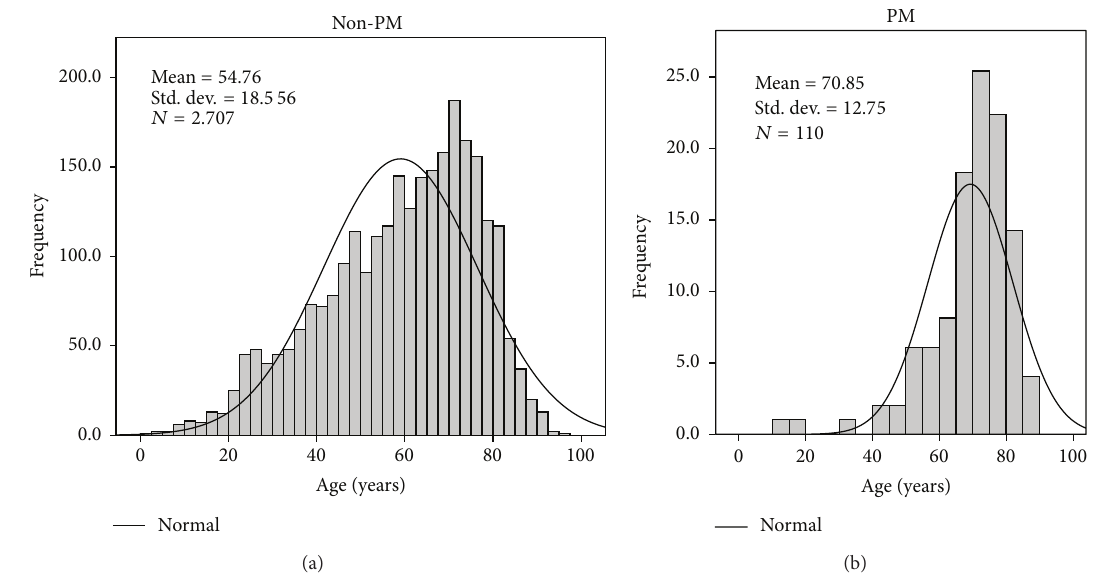
Figure 1: Age histograms from both groups without pacemaker (a) and with pacemaker (b).